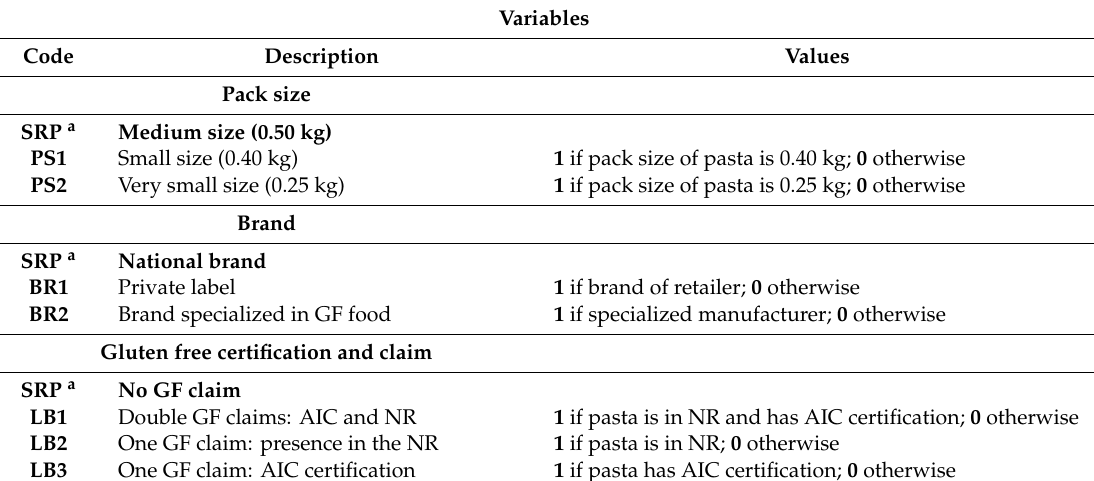
Table 3. Variable codification for the hedonic price